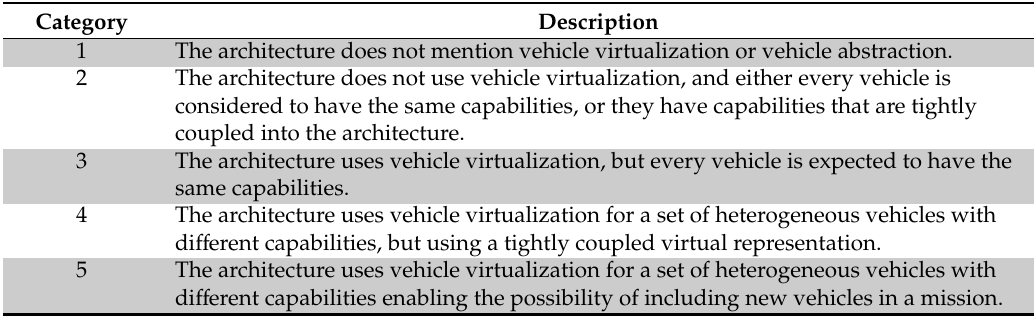
Table 4. Virtualization